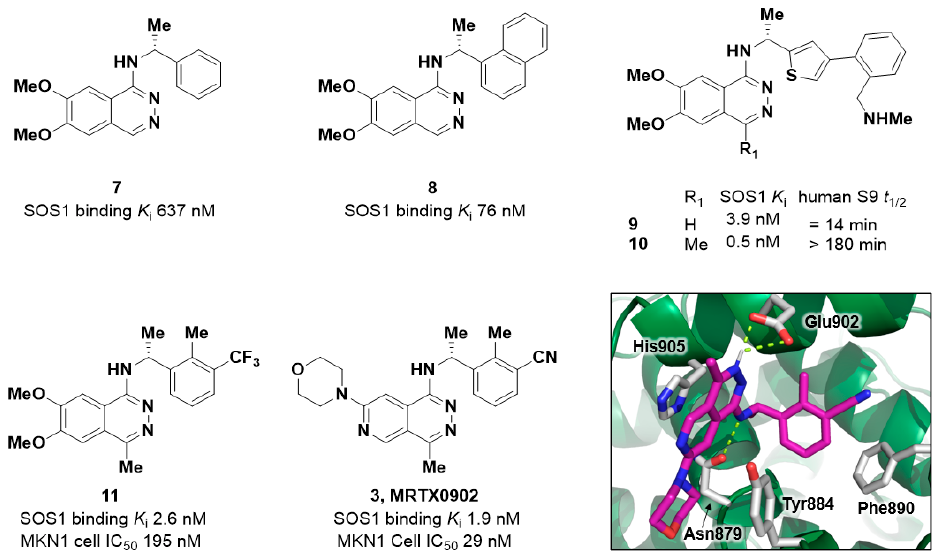
Figure 5. Exemplar compounds highlighting the potency and physiochemical property optimization of the phthalazine scaffold, resulting in the discovery of MRTX0902 ( 3 ). X-ray co-crystal structure of MRTX0902 bound to SOS1 (PDB 7UKR).